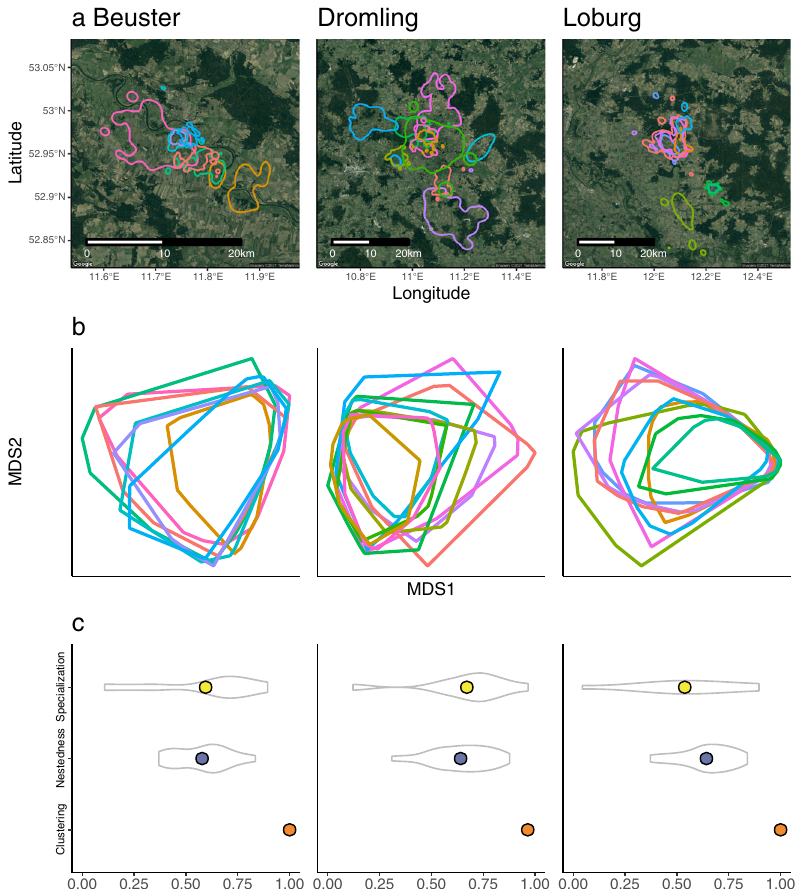
Fig. 2 Home range and environmental niche con fi gurations of 26 white storks (Ciconia ciconia) in three populations during the 2015 breeding season. a Individual home ranges, with lines representing 95% contours and colors identifying single individuals. b , c Geometric con fi guration and associated metrics of individual niches of the individuals shown in ( a ). Individuals are arranged on a specialist-to- generalist gradient, with individual niches extending into unique environmental space as their niche volume increases. See Fig. S2 for other years (2013 – 2016) which display similar patterns. b Visual representation of niche geometry and con fi guration in reduced two-dimensional space. Dimension reduction was performed on the estimated hypervolumes using non-metric multidimensional scaling (NMDS) on a subset of 1000 points from each hypervolume. Polygons represent the 95% outer contour of each individual niche. Colors and individuals are consistent with those in ( a ). c Specialization, nestedness, and clustering metrics for the three populations, calculated on the fi ve-dimensional niches. All metrics range from 0 (low) to 1 (high). Colored points represent the population-level metric and violin plots characterize the distribution of individual or pairwise metrics for specialization and nestedness, respectively. See Fig. S3 for distributions of these metrics under three null models (further described in the methods section). Basemap images in ( a ): Google, ©2021